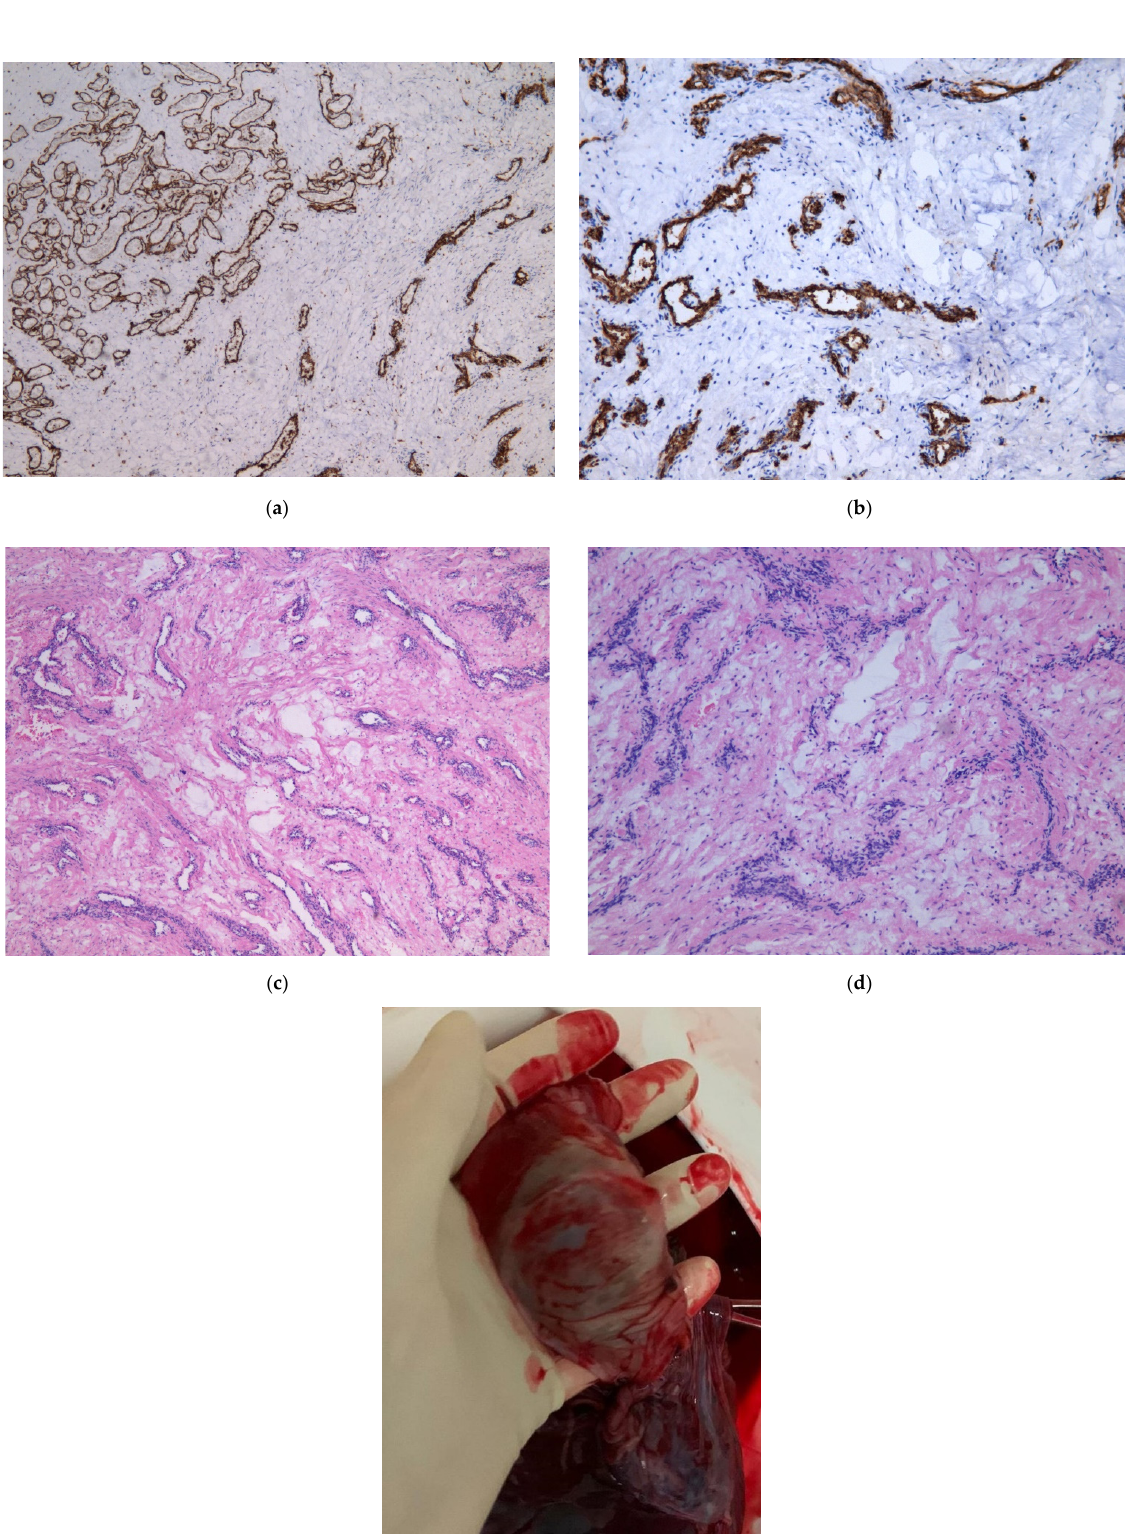
Figure 4. ( a ) Microscopic appearance of the tumor, CD31 in thin wall of the vessels, ×5; ( b ) Micro- scopic appearance of the tumor, CD34 in thin wall of the vessels, ×10; ( c ) Microscopic appearance of the tumor, small anastomosing vascular structures surrounded by myxoid degeneration, ×5; ( d ) Mi- croscopic appearance of the tumor, obliterated small vessels in myxoid degeneration, ×10; ( e ) Mac- roscopic appearance of the tumor.